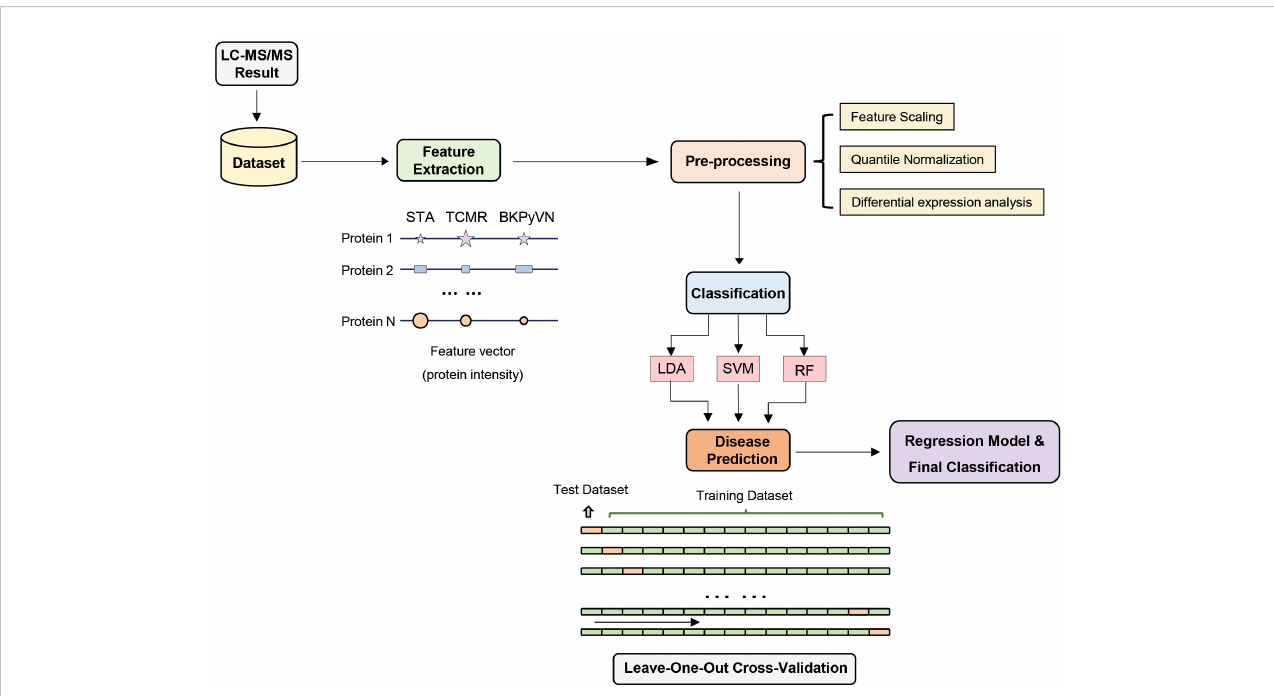
FIGURE 3 Development of machine learning derived disease prediction model for TCMR, BKPyVN and STA. With the LC-MS/MS data sets of the total of 15 kidney transplant FFPE samples collected, the protein names and corresponding intensities were obtained after database search. Feature selection process selects the critical features (e.g., intensity) for the prediction of kidney rejection disease. After feature selection, preprocessing procedures such as outlier removal, feature scaling (log transformation) and quantile normalization were performed. Various classi fi cation techniques were applied to the preprocessed data, with performance evaluated via leave-one-out cross-validation strategy. For a total of 15 samples (5 TCMR + 5 BKPyVN + 5 STA), 14 were used as training dataset and the other one as test dataset. Finally, the optimized biomarker panel and disease prediction model were